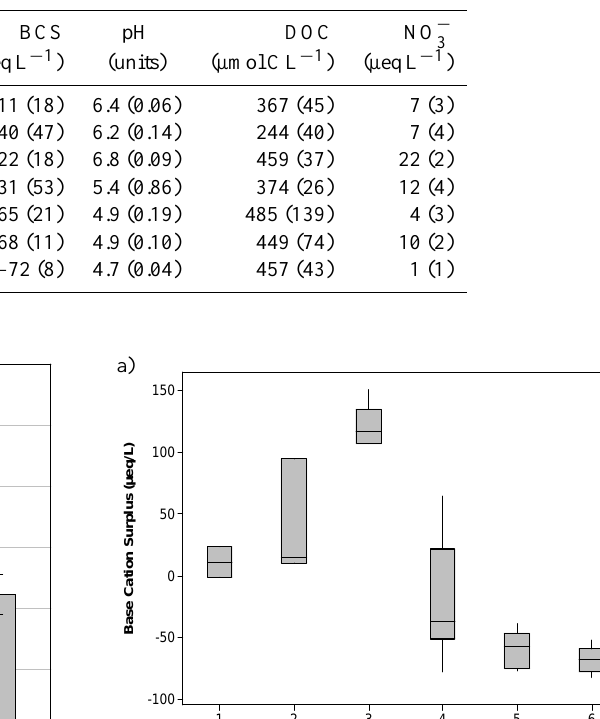
Table 1. Grass Pond stream chemistry means (standard deviation) analyzed from stream samples collected in October 2008.